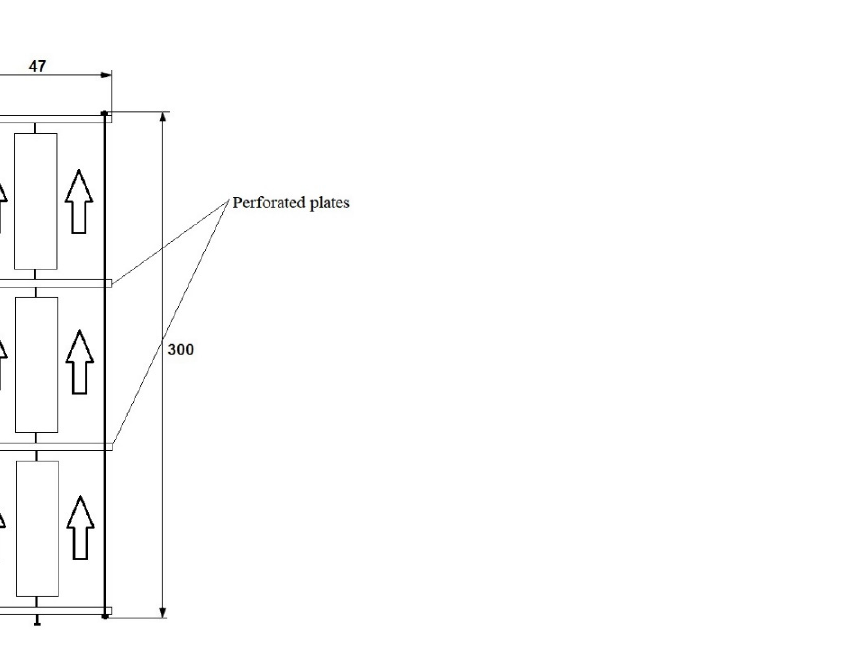
Figure 3. Arrangement of sandstone cores inside the plastic pipe [27].